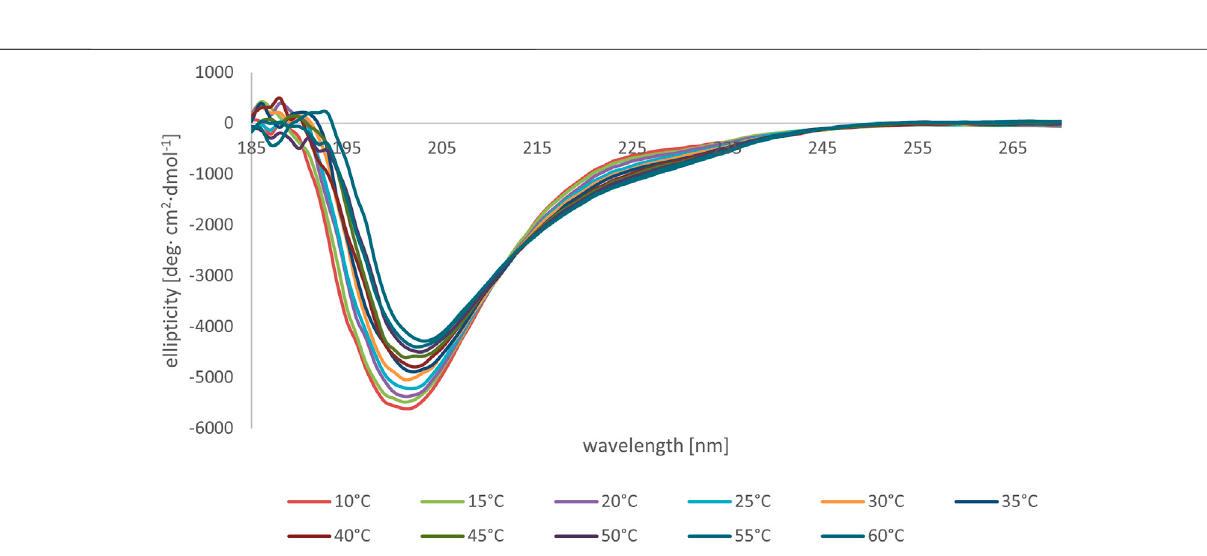
FIGURE 5 | CD spectra of peptide MBP (81 – 106) (1) in PBS at various